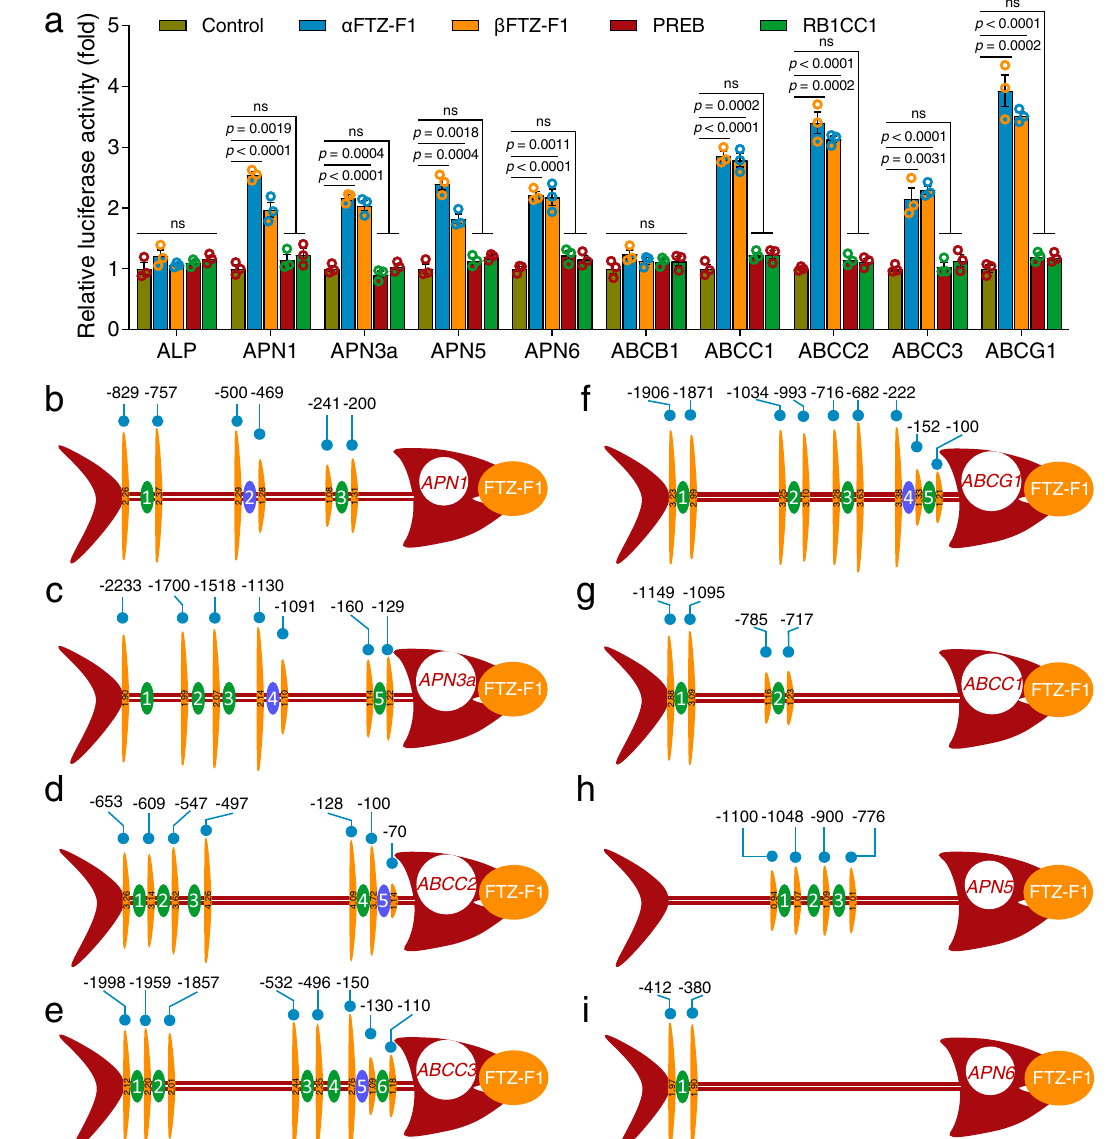
Fig. 1 | FTZ-F1 regulatestheexpression ofmultiplemidgut Cry toxin receptors andnon-receptorparalogousgenes.a EffectsoffourTFsonthepromoteractivity of Bt receptor genes and non-receptor paralogous genes. Each pAc5.1-TF expres- sion vector was co-transfected with a pGL4.10-promoter reporter plasmid into S2 cellstodetectluciferaseactivity.AnemptypAc5.1vectorwasusedasacontrol.The relative luciferase activity (fold) was calculated based on the value of the control, which was assigned an arbitrary value of 1. Differences between control and TF- treated groups were tested by one-way ANOVA with Tukey ’ s test. Data were pre- sented as mean values±SEM ( n =3), ns, not signi fi cant, p values are shown. b – i Preliminary identi fi cation of functional FBSs in the promoters of midgut genes bydual-luciferasereporterassays.TheFTZ-F1expressionvectorwasco-transfected with varioustruncatedconstructs ofmidgut gene promotersto identify functional